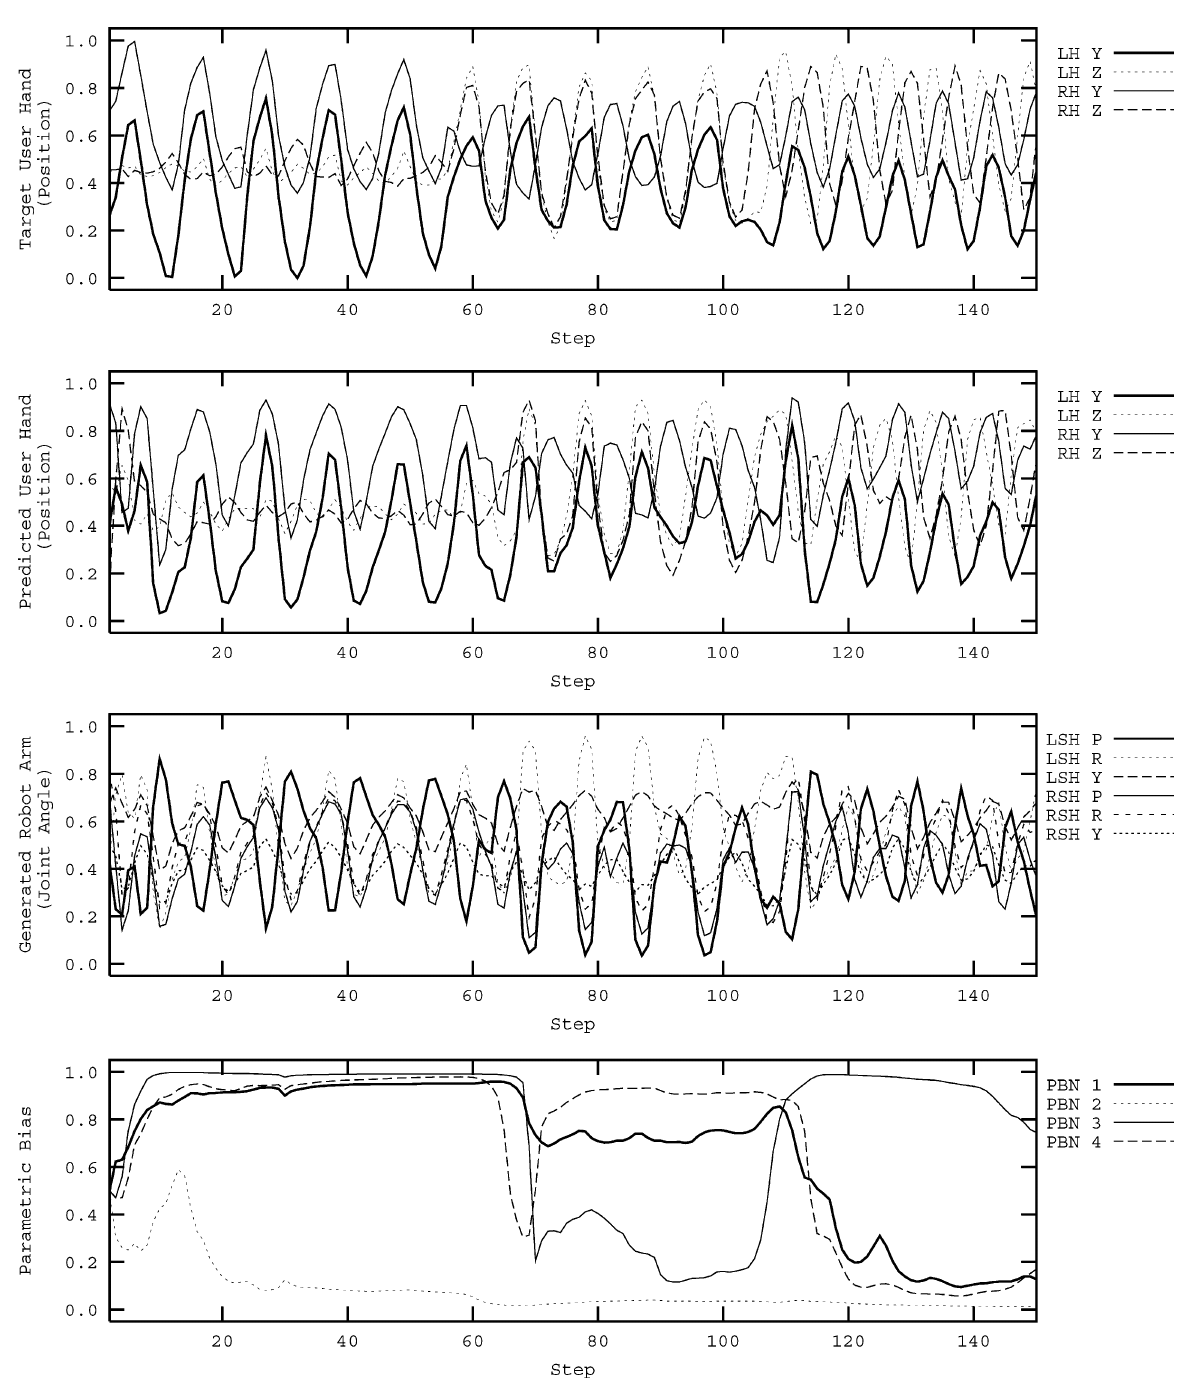
Figure 5. Switching of the robot movement pattern among three learned patterns as initiated by switching of user hand movement.